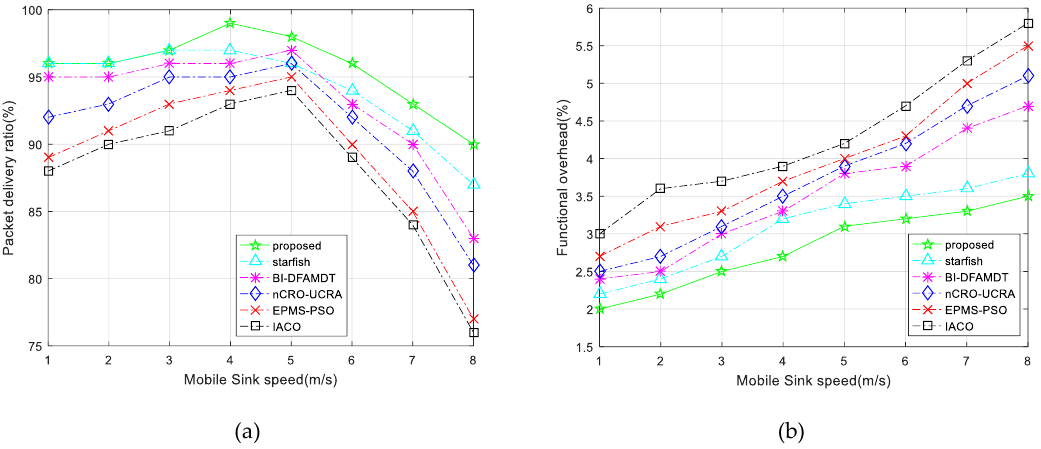
Figure 17. Comparison of the proposed scheme with existing algorithms versus packet delivery ratio and functional overhead: ( a ) Packet delivery ratio; and, ( b ) Functional overhead. x.